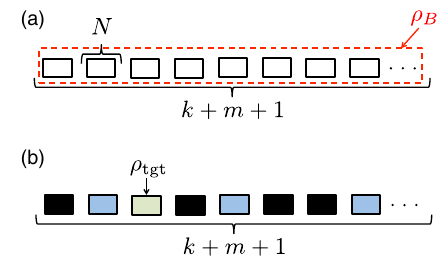
FIG. 2. (a) The quantum state ρ in step 1. Each rectangle B represents a register that stores N qubits, and ρ consists of k þ B m þ 1 registers. If the prover is honest, the state of each register is the ideal quantum state. On the other hand, if the prover is malicious, registers may be entangled with each other. (b) A quantum state in step 2. Randomly chosen black registers are discarded, and then the remaining m blue registers and one green register become close to i.i.d. samples because of the quantum de Finetti theorem [63]. Randomly chosen m blue registers are used for the test. The green register is the target state ρ tgt